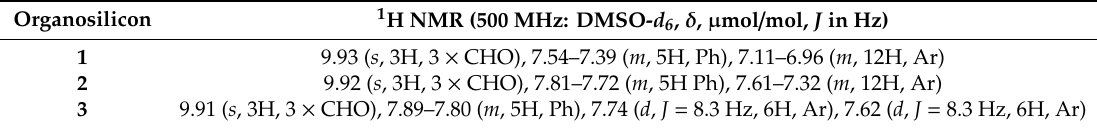
Table 1. Common FTIR absorption bands of organosilicons 1–3 .